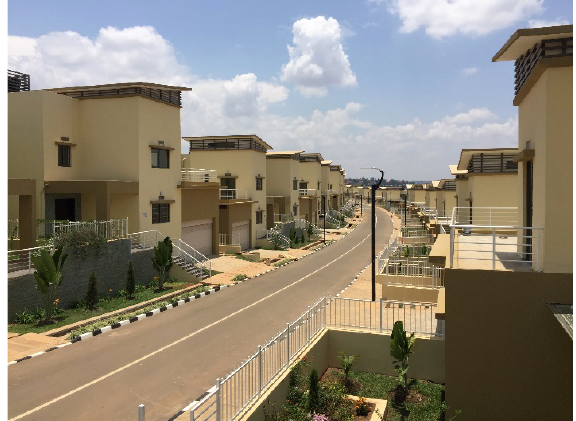
Figure 55. The Umudugudu Kigali Vision: Twin houses (3–4 Bedrooms); back yard. Photograph by Manlio Michieletto.